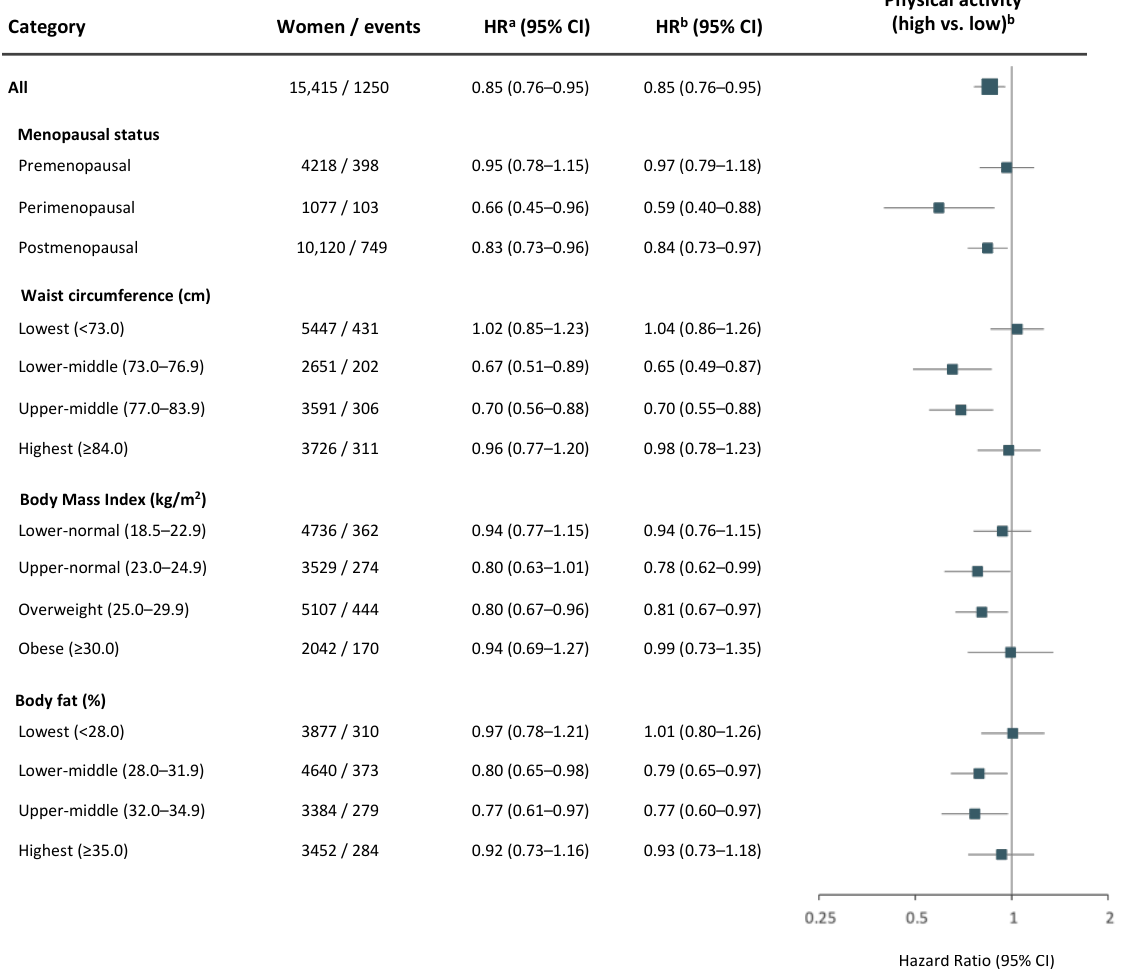
Figure 3. Physical activity and risk of breast cancer over the entire study follow-up. Age- and multivariable-adjusted hazard ratios (HR) with 95% CI for a high versus low level of physical activity among all women, and by menopausal status or body composition. Women and breast cancer events shown represent the numbers available in the multivariable model. The forest plot illustrates multivariable-adjusted HR with 95% CI. a Model adjusted for age at baseline. b Multivariable model adjusted for age at baseline, age at menarche, parity, age at first childbirth, oral contraceptive use, current hormone replacement therapy use, socioeconomic index, and alcohol consumption. Models for all women or stratified by body composition (waist circumference, BMI, or body fat percentage) were additionally adjusted for age at menopause.